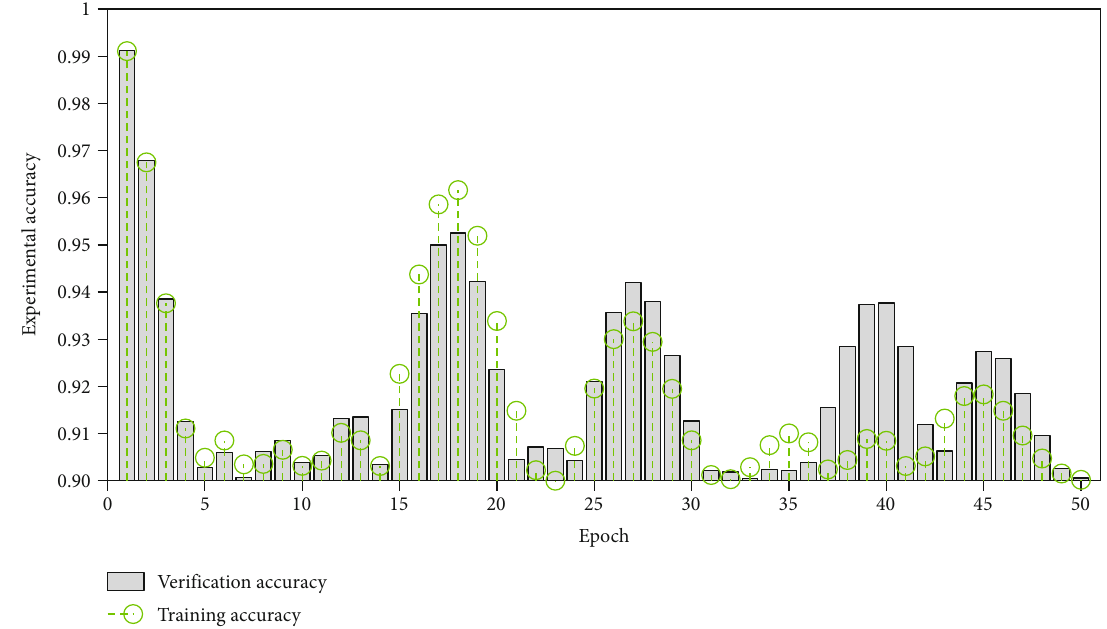
Figure 8: Accuracy map of automatic recognition of capital letter images based on partial di ff erential equation convolutional neural network based on mean curvature